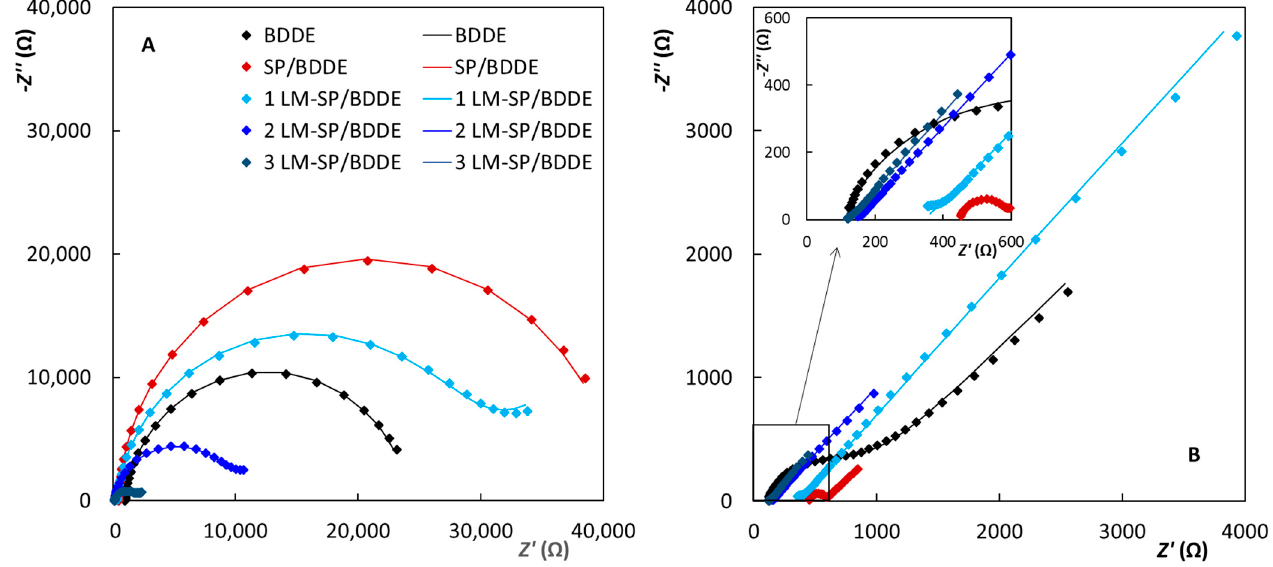
Figure 5. Electrochemical impedance spectra (Nyquist plots) recorded on the tested sensors in 2.5 mmol L − 1 [Fe(CN) 6 ] 4 − /3 − ( A ) and [Ru(NH 3 ) 6 ] 2+/3+ ( B ) in 0.1 mol L − 1 KCl ( f = 10–10,000 Hz, A = 10 mV).